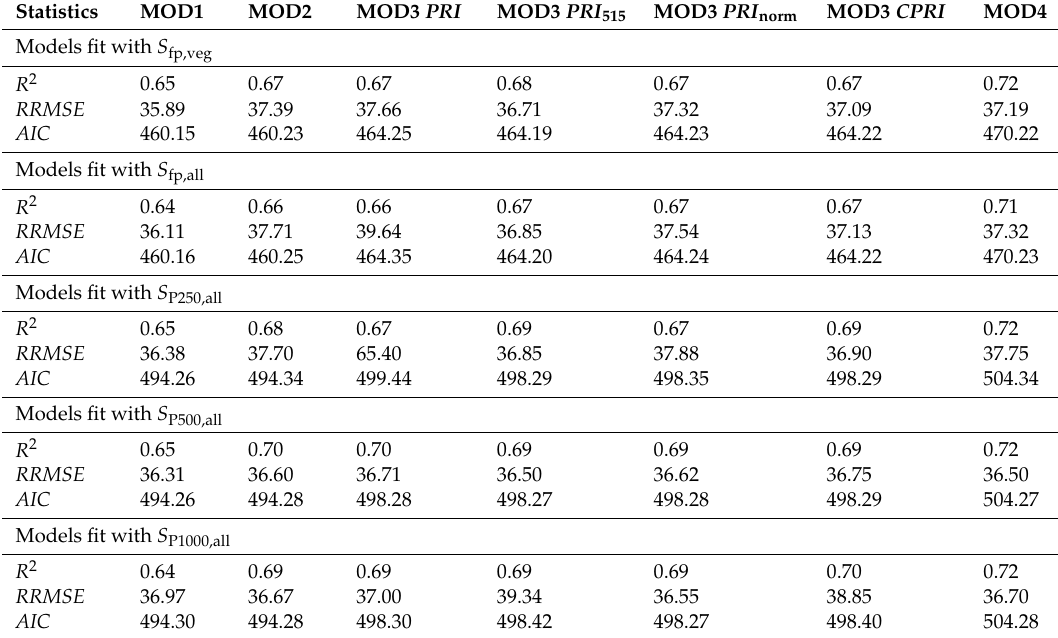
Table 5. Statistics for the different model fits using the “Flight” dataset as well as the weighted spectral signature of vegetation covers or different synthetic pixel